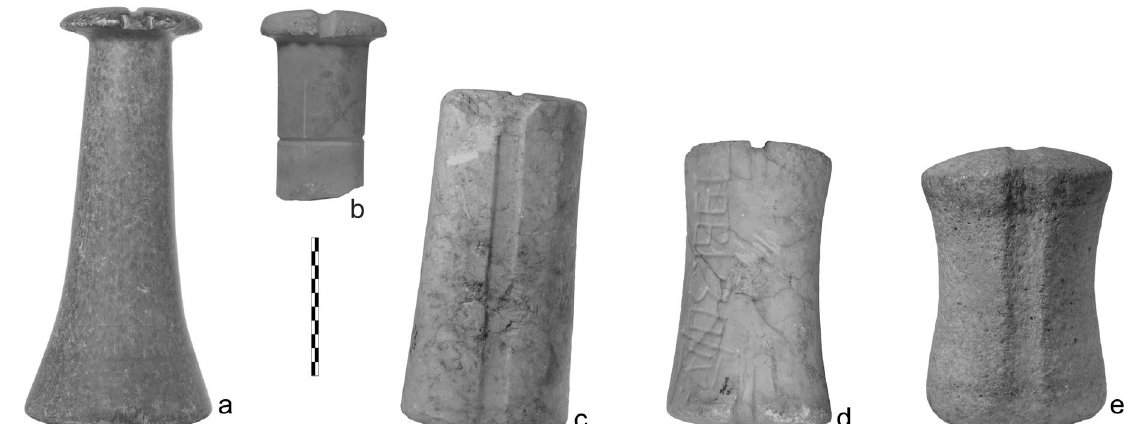
Figure 13. Various types of miniature columns from Altyn Depe: a, b. truncated-conical with mushroom-shape top base; c. cylindrical; d, e. biconical (photo from the scientific archive of the Institute for the History of Material Culture, Russian Academy of Sciences (RAS) I 117934, I 117939, I 117937, I 117932, I 117938) (d. miniature column reused). Scale bar is 10 cm long, separated into 1 cm segments.